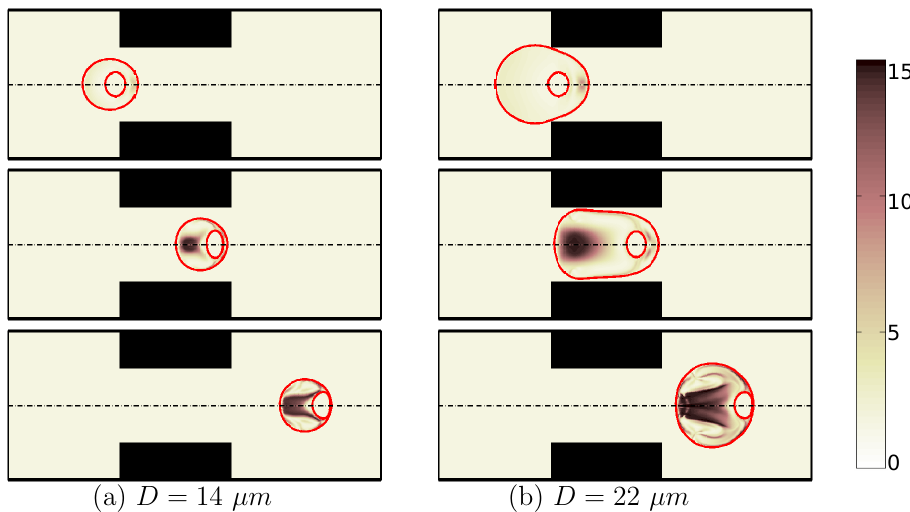
Figure 5. Shape evolution of an encapsulated HL60 cell through the constricted microchannel at different locations of channel. The encapsulating droplet radius is: D = 14 µ m ( a ) and D = 22 µ m ( b ). The color bar and contours represent the square root of trace of conformation tensor inside the cell and the shell fluid. ( λ = 0.1s, β = 0.5, Ca = 0.00076 and Re =